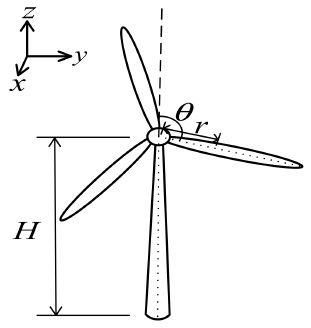
Figure 1. Schematic of some wind turbine